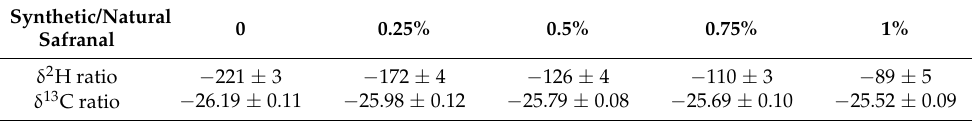
Table 1. Isotope analysis of adulterated Iranian saffron by synthetic safranal (mean of five analyses). Synthetic/Natural